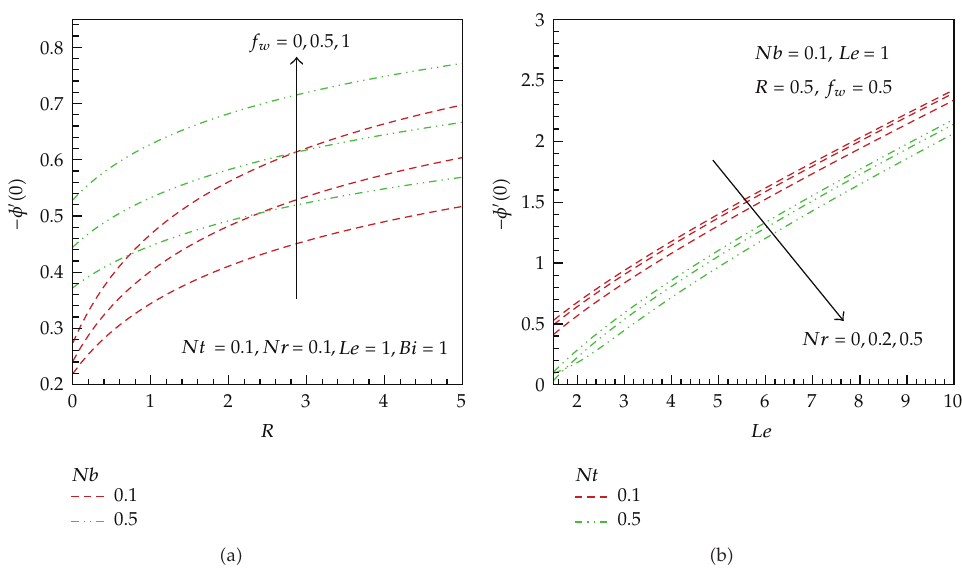
Figure 8: Variation of local mass transfer rate with (cid:3) a (cid:4) Brownian motion, radiation, and suction/injection parameters, (cid:3) b (cid:4) Lewis number, buoyancy ratio, and thermophoresis parameters.